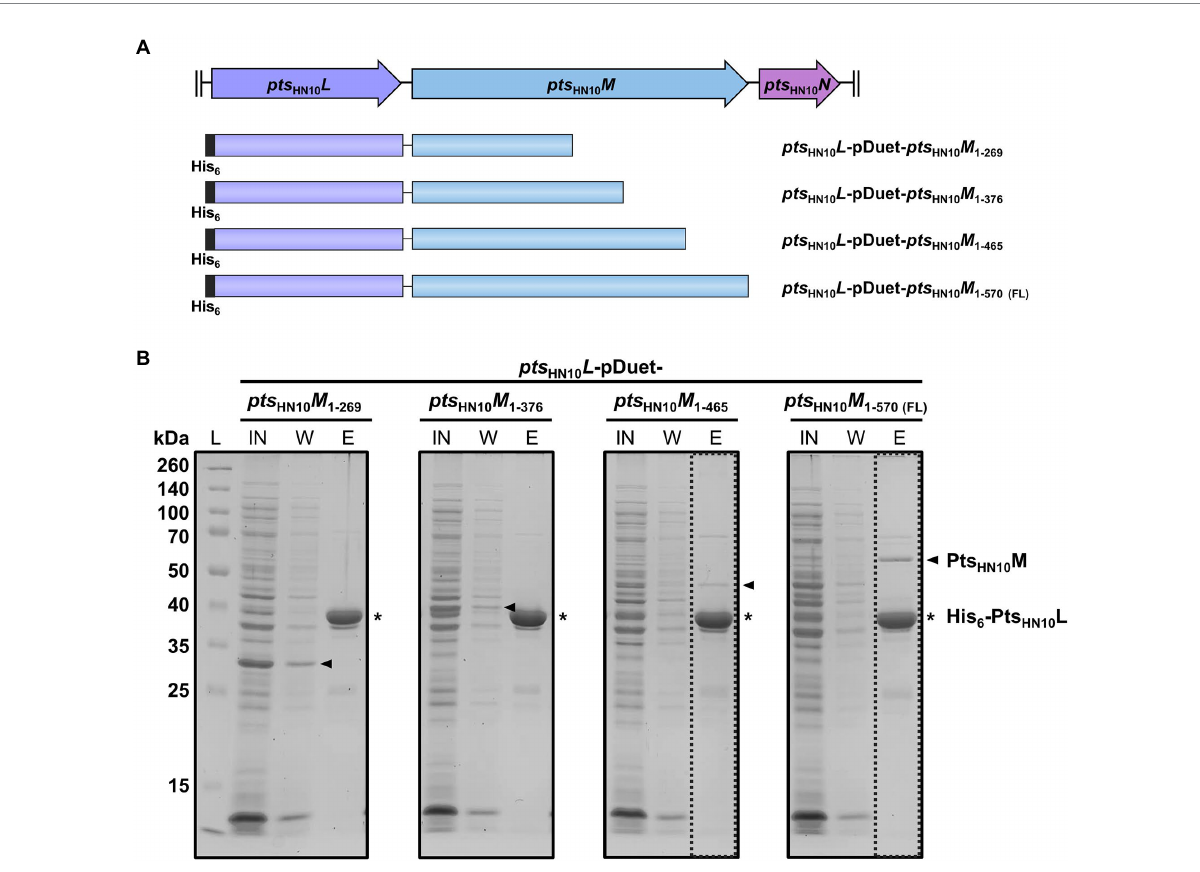
FIGURE 3 C-terminus of Pts HN10 M is required for interaction with Pts HN10 L. (A) The schematic representation of four different constructs for co-expression of His 6 -Pts HN10 L and truncated Pts HN10 M variants. (B) The fractions from protein co-expression purification were collected and visualized using SDS- PAGE followed by Coomassie staining. The bands of His 6 -Pts HN10 L and truncated Pts HN10 M proteins are indicated as asterisk and arrowhead, respectively. L, protein ladder; IN, input; W, wash fraction; E, elution fraction. The dashed boxes present an elution fraction that Pts HN10 M co-elutes with Pts HN10